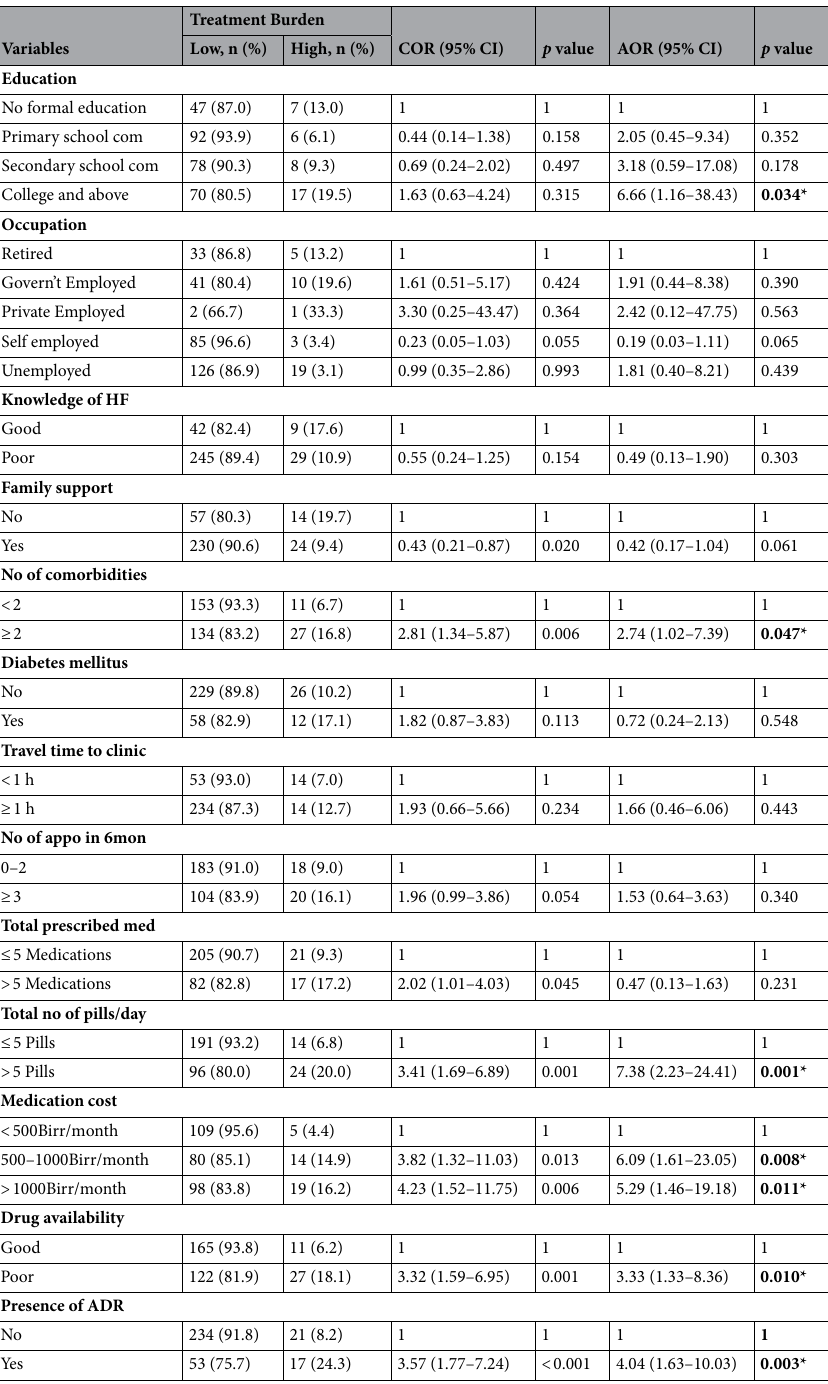
Table 5. Univariable and multivariable logistic regression analysis of factors associated with treatment burden among patients with heart failure attending adult cardiac clinic of Tikur Anbessa Specialized Hospital, Addis Ababa, Ethiopia, August 01-September 30, 2021 (n = 325). COR crude odds ratio, AOR adjusted odds ratio, CI confidence interval, Govern’t government, Appo appointment, HF heart failure, ADR adverse drug reaction, No number, mon month, Med medication, com completed. *significant at p < 0.05. Significant values are in